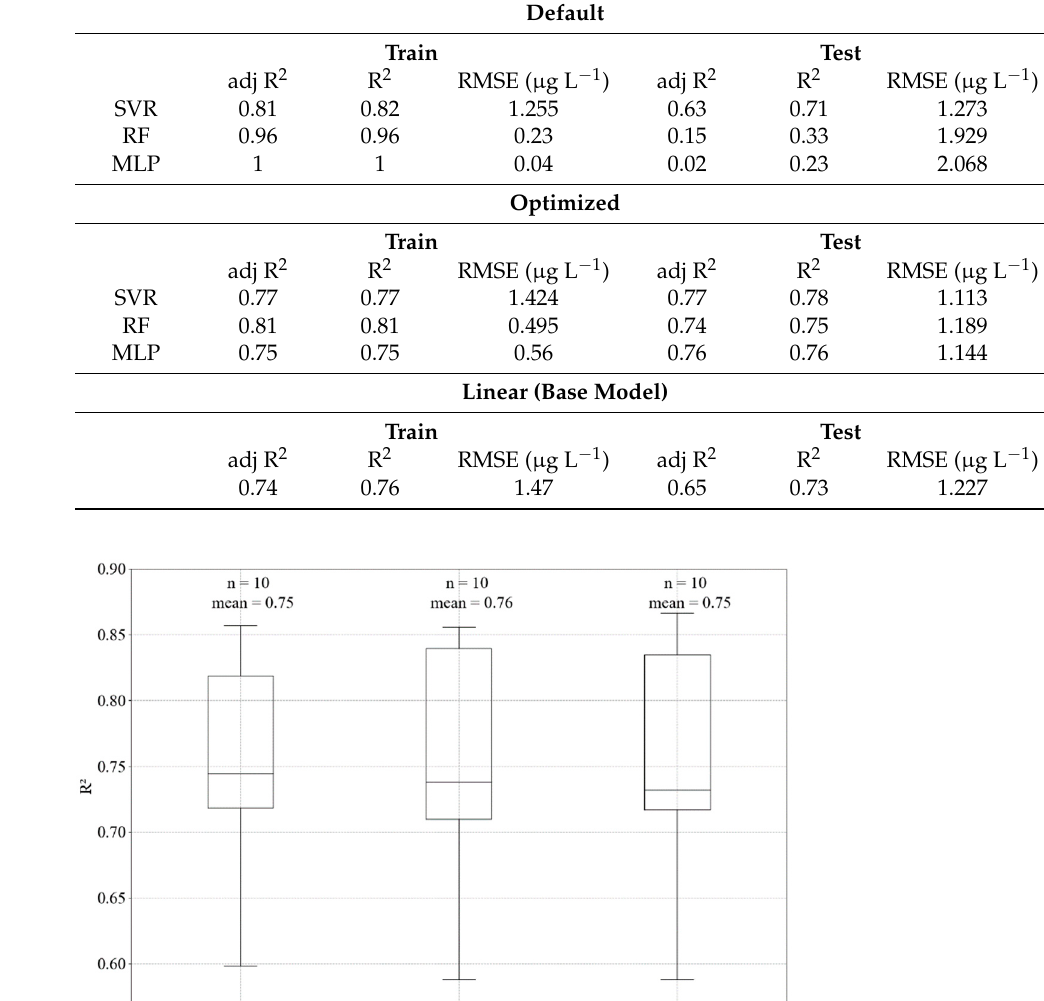
Table 5. Comparison of nonoptimized (default) and optimized model performances for predicting chlorophyll-a concentration during training (train) and testing (test) steps. The linear model serves as a base model.